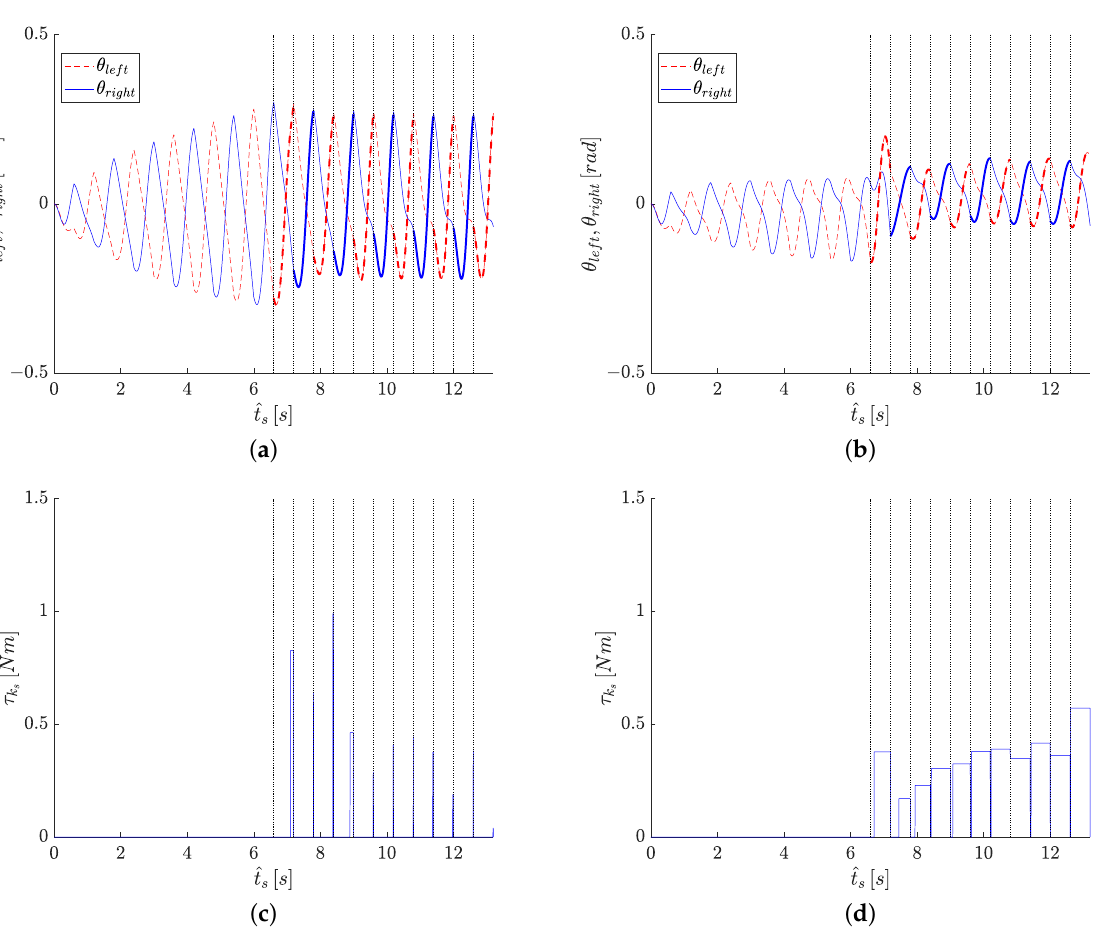
Figure 8. Angular displacements of the left θ left and right θ right leg of the SPBR along with the PWS and SPWS: ( a ) S-C design.